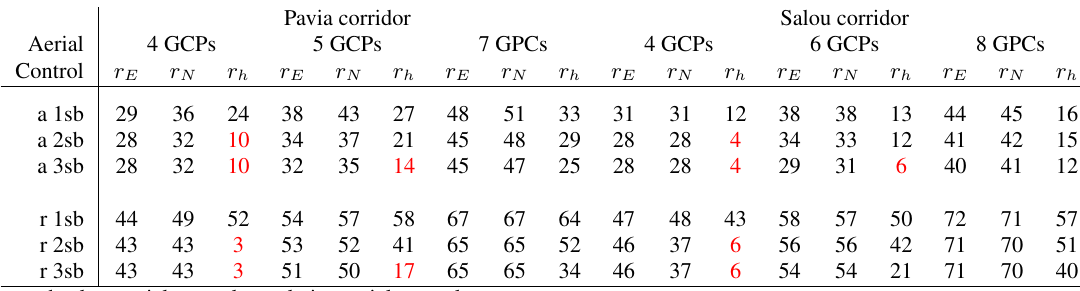
Table 6: GCP redundancy numbers (%) of Fast AT for P-C and S-C depending on the sub-block and GCP configurations. Block Pavia block